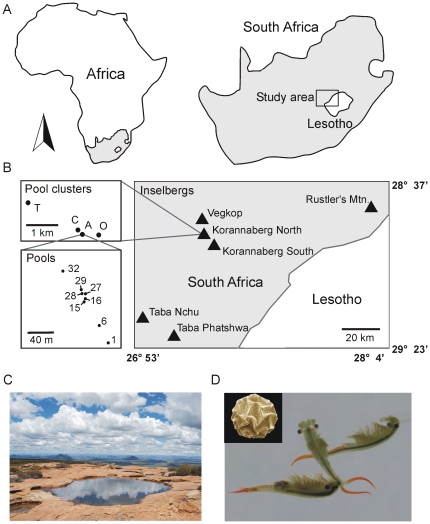
Study area and model organism.(a) Location of the study area in Africa. (b) Map of the study area illustrating the spatial hierarchical structure of the habitat: location of different inselbergs housing pool clusters with fairy shrimp populations in the regional landscape (right), location of different pool clusters on a single inselberg (Korannaberg North) (top left) and different populations embedded in one pool cluster (cluster A, Korannaberg North) (bottom left). (c) Typical rock pool located at the summit of the inselberg Taba Phatshwa, Free State, South Africa (Photo courtesy of Bram Vanschoenwinkel), (d) Branchipodopsis fairy shrimp (Photo courtesy of Dirk Ercken); right: B. cf. wolfi male, middle: B. drakensbergensis male, left: B. sp. female. inset: scanning electron microscopic picture of a B. sp. dormant egg (230 µm diameter). Females and dormant eggs of both species cannot be distinguished morphologically.